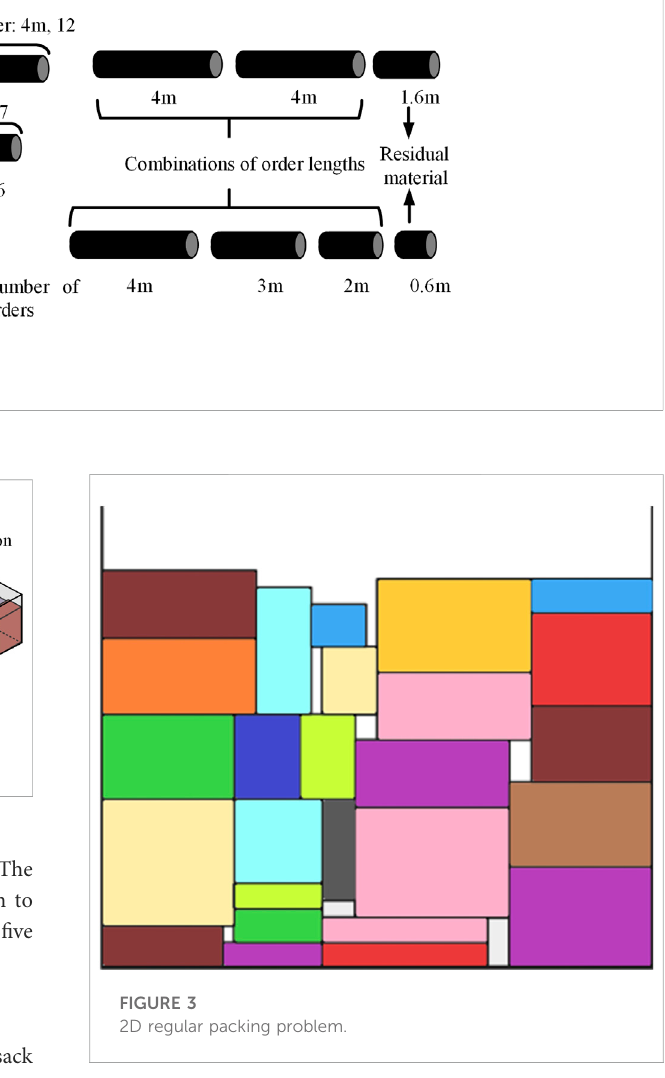
Figure 5. The de fi nition of variables is shown in Table 3.